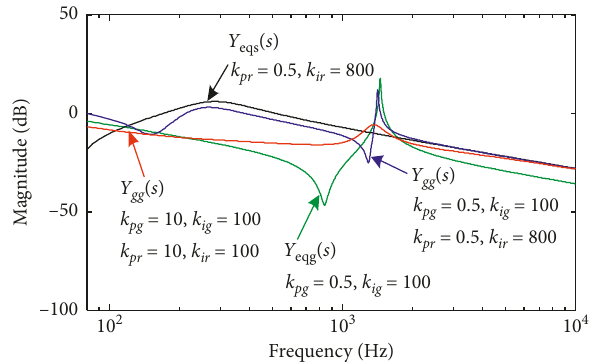
Figure 11: Magnitude-frequency curves of Y ( s ) Y gg